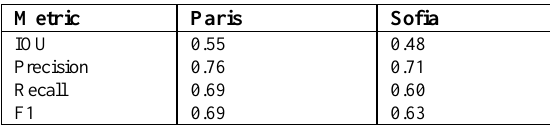
Table 1. Comparison on performance on test data.